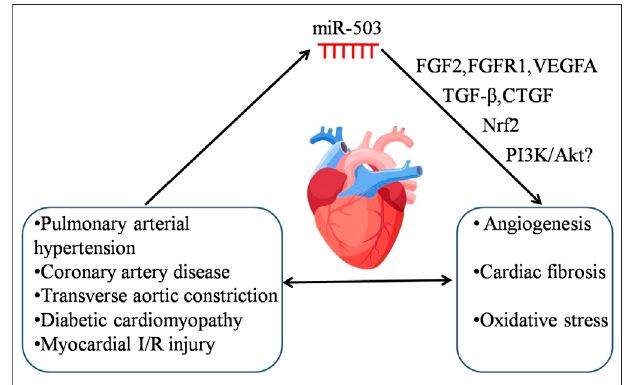
FIGURE 1 | The potential mechanism of miR-503 in regulating cardiovascular disease. Cardiovascular disease induces the abnormal expression of miR-503. The dysregulation of miR-503 may contribute to various pathologies, e.g., angiogenesis, cardiac fi brosis and oxidative stress, and it would subsequently aggravate the severity of cardiovascular disease. The following targets, FGF2, FGFR1, VEGFA, TGF- β , CTGF, Nrf2, and PI3K/Akt may be involved inthe pathological processes of cardiovascular disease regulated by